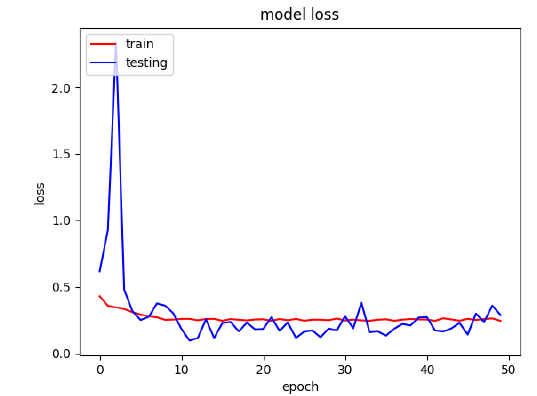
Figure 9. Non-COVID-19 CXR Model Loss Graph.